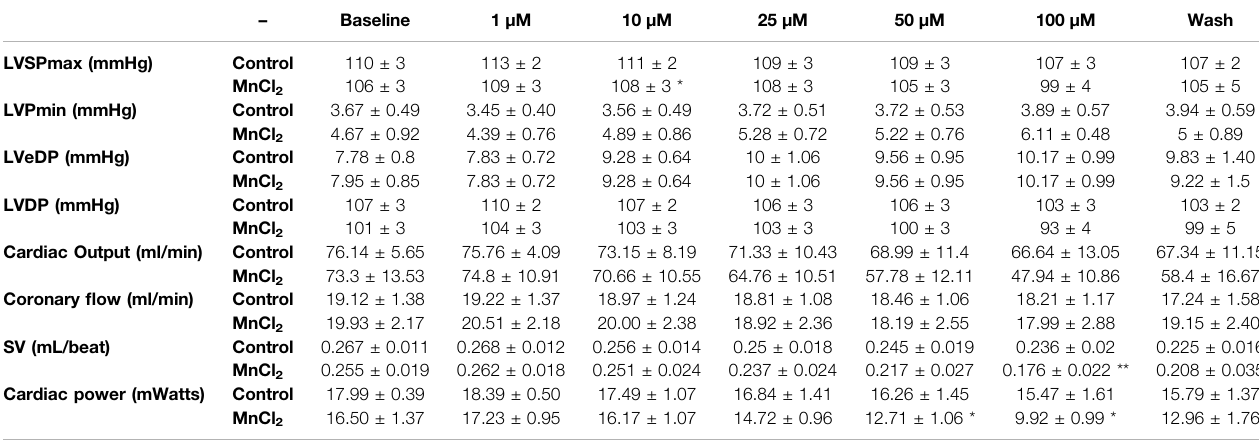
TABLE 1 | Hemodynamic parameters of isolated working rat hearts perfused in the control group and MnCl 2 group . –